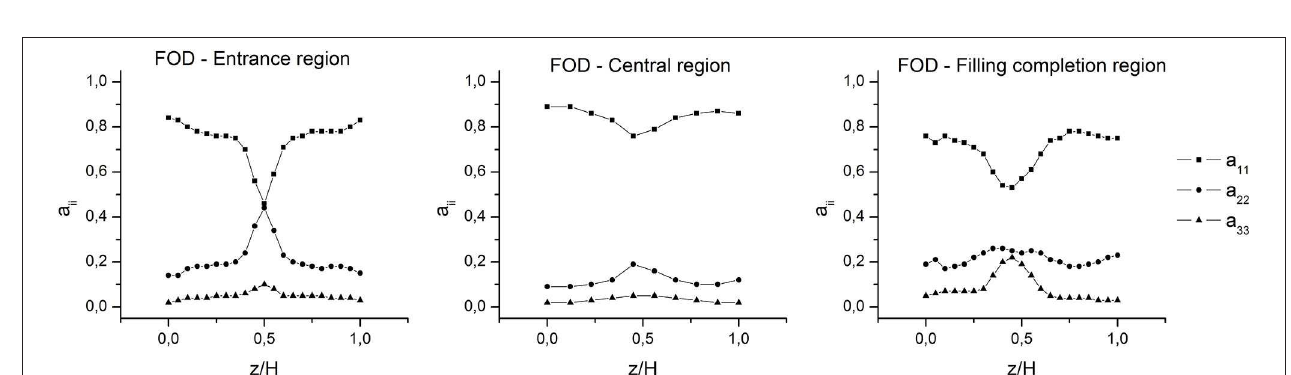
FIGURE 3 | Experimental a 11 , a 22, and a 33 orientation profiles at the regions of interest.